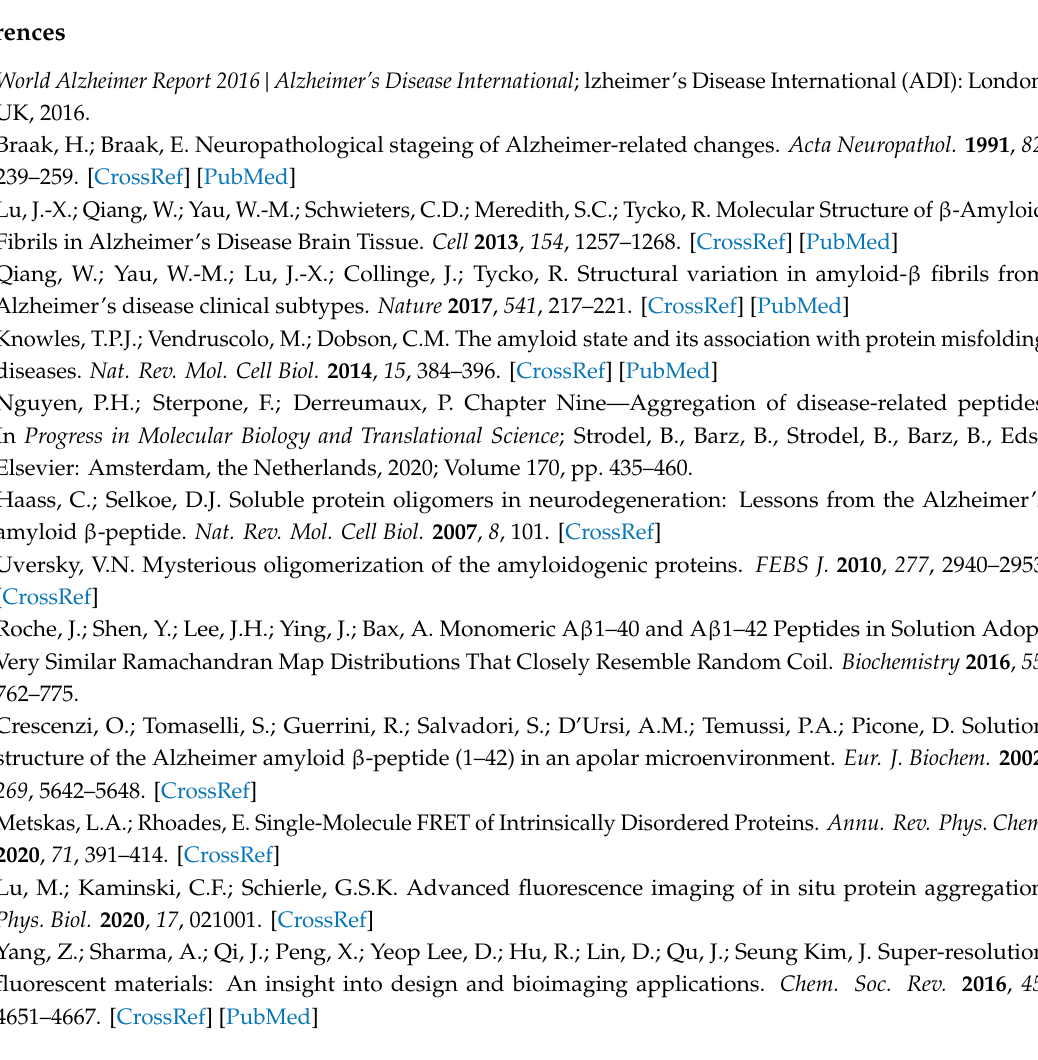
beta complex, Figure S2: The OFF state of the Alexa568-Amyloid beta complex. The blue circle shows the position of the extra bond in the OFF state, Figure S3: Summary of statistics regarding Radius of Gyration (left) and Solvent Accessible Surface Area (right) regarding the last 150 ns of the trajectory at T = 315 K replica. The RoG and SASA quantities were calculated in each frame along each trajectory and the most important statistical descriptors of the resulted distribution function (median, min-max, interquartile range) are presented for all the three systems. The dashed line shows the min, max values without outliers, the height of the box corresponds to the interquartile range and the line in the middle shows the median value, Figure S4: Snapshots to demonstrate the geometry of a close contact between SO3(-) and Arg5 (left) and between SO3(-) and Lys28 (right). The dye and its linkage were represented by the same color, Figure S5: The RMSD diagram of the C α atoms along the full trajectories (0 ns–250 ns) in all the three